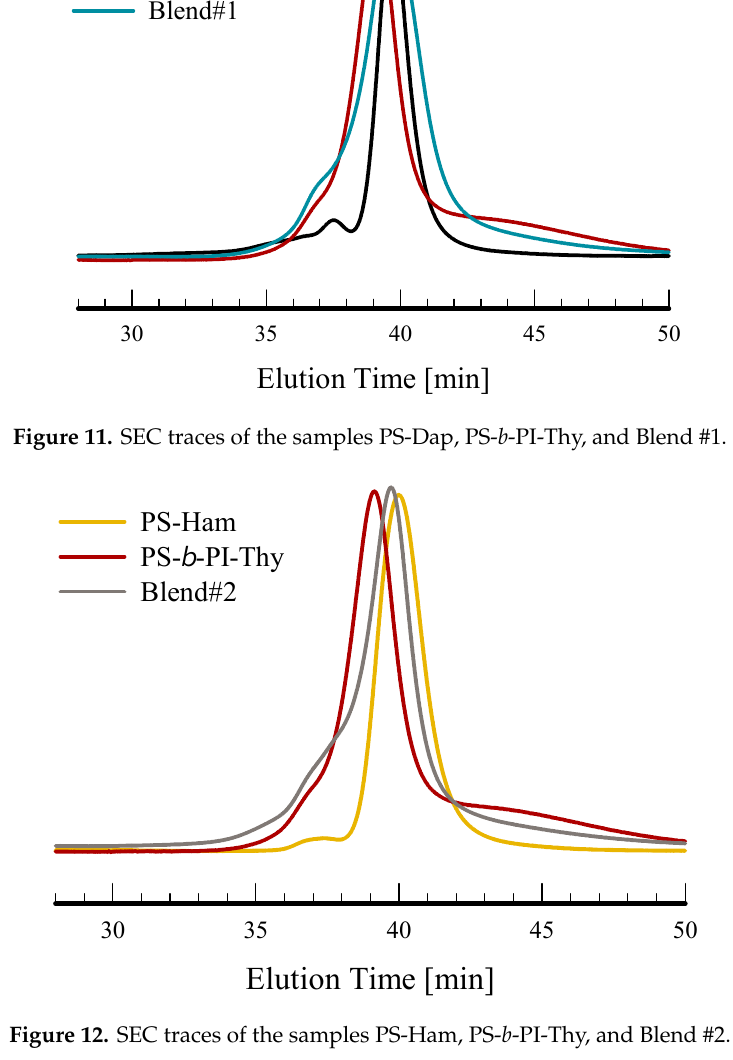
Figure 12. SEC traces of the samples PS ‐ Ham, PS ‐ b ‐ PI ‐ Thy, and Blend #2.